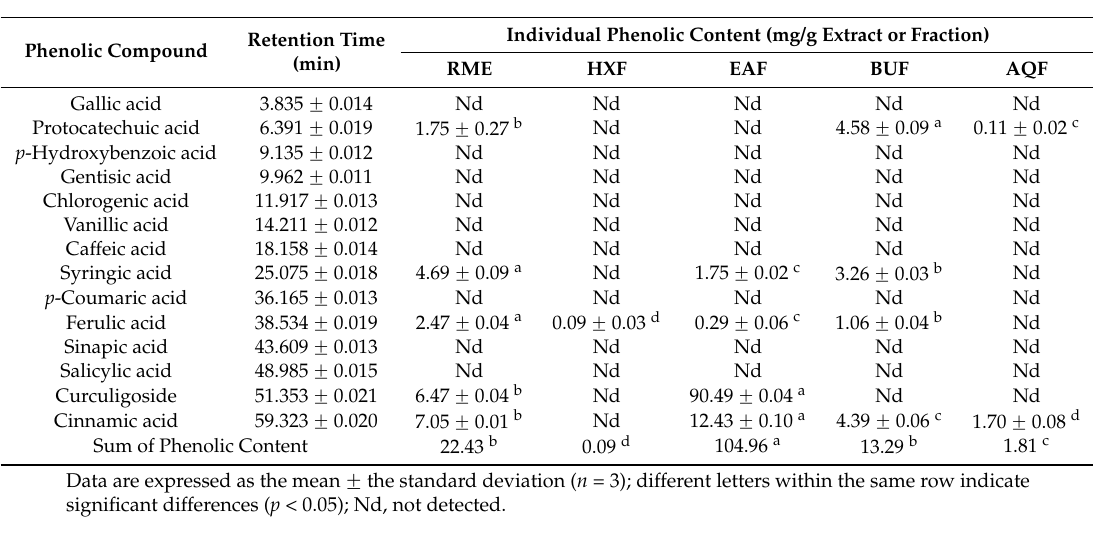
Table 2. Phenolic compositions by HPLC-DAD analysis.